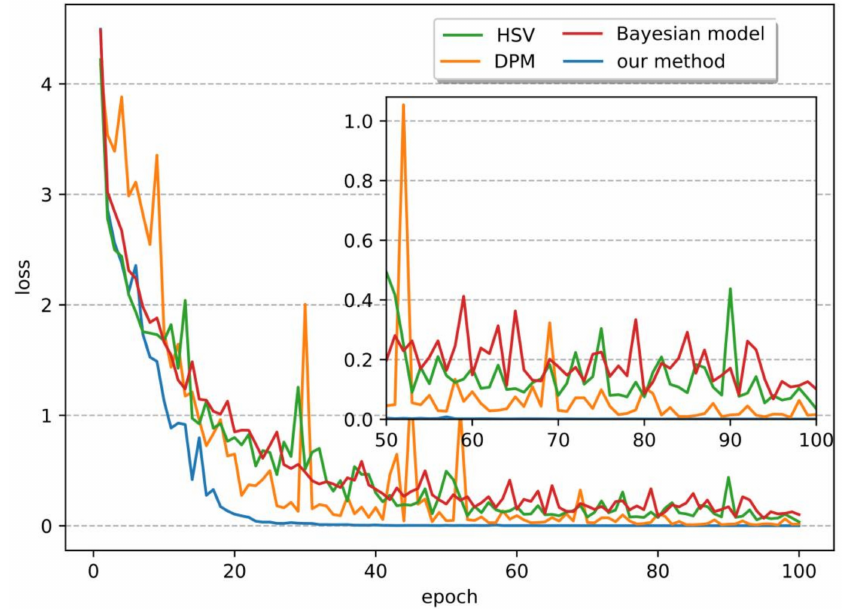
Figure 10. Convergence of the Bayesian attention model, DPM model, skin-color-based HSV model, and the proposed